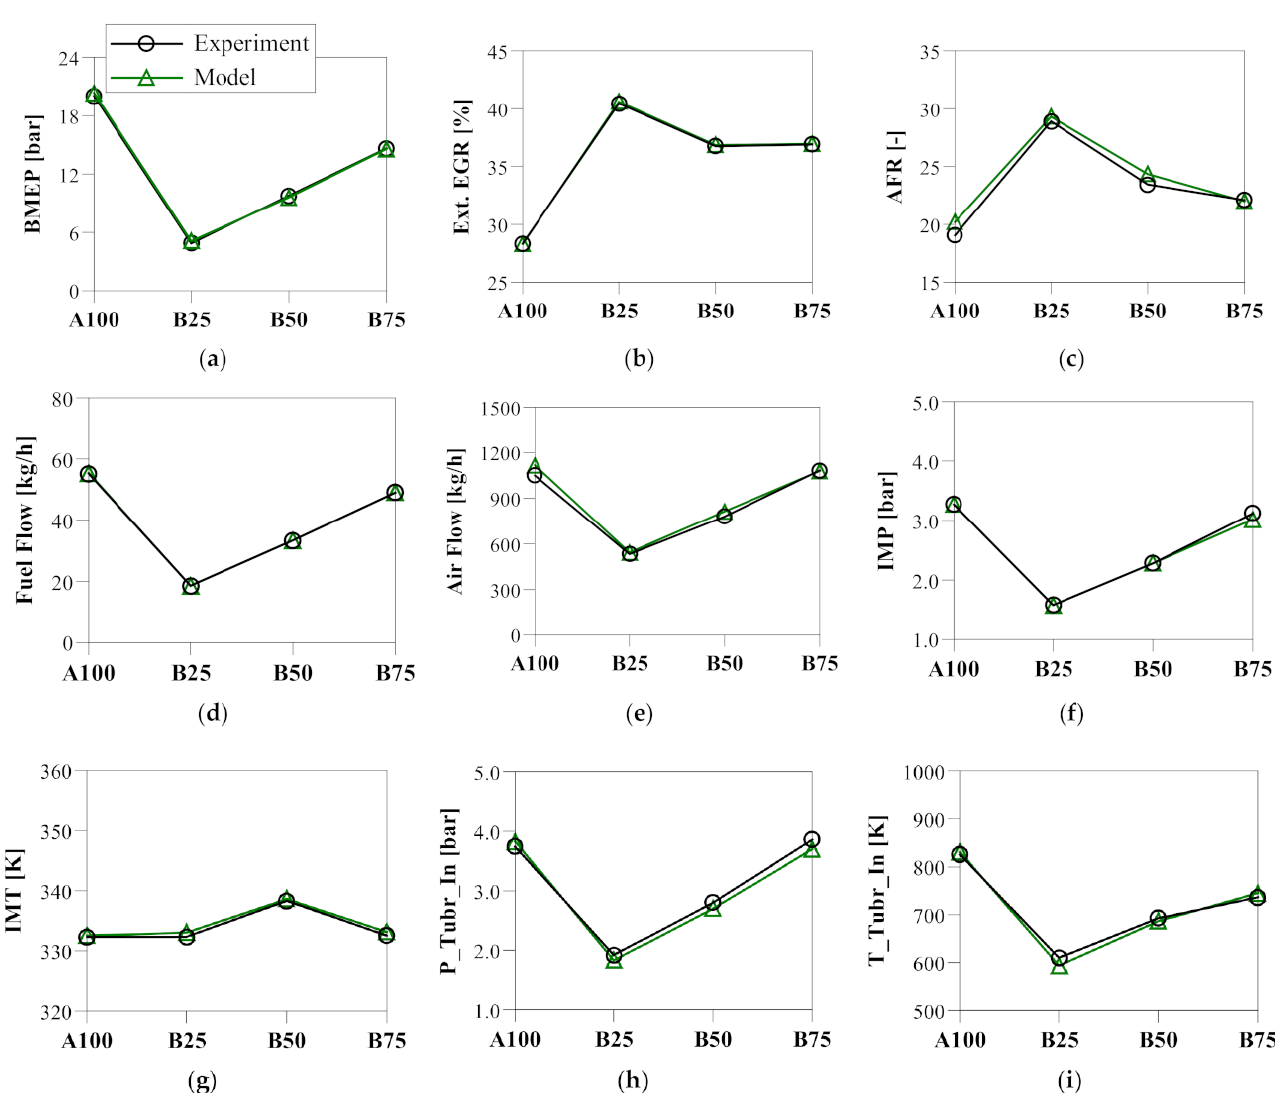
Figure 8. Comparison of key Gen1 GCI engine operating boundary between experimental data and model predictions: ( a ) BMEP; ( b ) external EGR; ( c ) AFR; ( d ) fuel flow; ( e ) air flow; ( f ) intake manifold pressure (IMP); ( g ) intake manifold temperature (IMT); ( h ) turbine inlet pressure; ( i ) turbine inlet